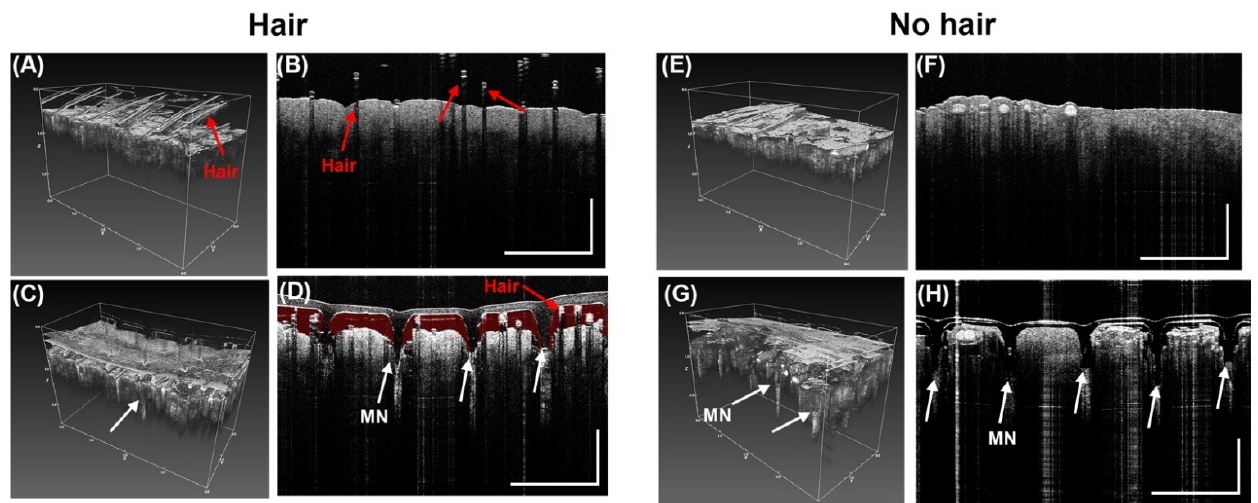
Figure 7. Representative OCT images from before and after penetrations of PVA MN array with microneedle height of 500 μ m (Design B) into porcine ear skin. ( A ) Without a MN there are no holes in the skin with hair in 3D OCT image, ( B ) 2D cross-sectional (B-scan) image in skin sample with hair ( C ) MN inserted into sample with hair in 3D OCT image, ( D ) 2D cross-sectional (B-scan) image of MN inserted into skin sample with hair (red false coloring added to show gap between MN and skin). Scale bar 1000 μ m. ( E ) Porcine skin with no hair in 3D OCT image before MN application. ( F ) 2D cross-sectional (B-scan) image in skin sample with no hair before MN application, ( G ) MN inserted into sample with no hair in 3D OCT image, ( H ) 2D cross-sectional (B-scan) image of MN inserted into skin sample with no hair. White arrows show the holes in the epidermis of the pig skin showing penetration (n = 3). Scale bar 1000 μ m.